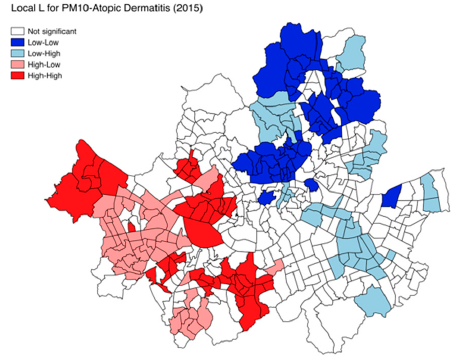
Figure 5. Map of Lee’s Local L for bivariate association between PM 10 and atopic dermatitis in Seoul.